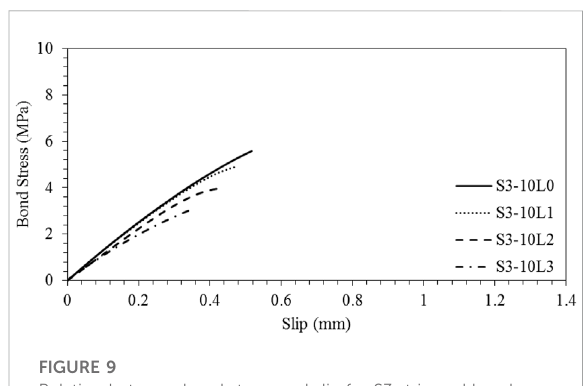
FIGURE 9 Relation between bond stress and slip for S3 strip and bond length of 100 mm.